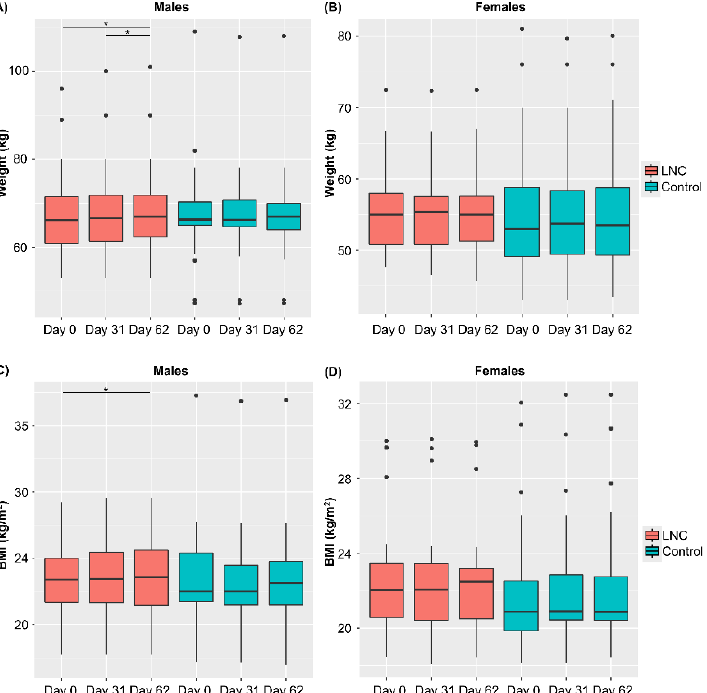
Figure 2. Changes in body weight and BMI following ingestion of SONOMONO NATTO POWDER CAPSULES TM . Each dot represents outliers. ( A ) Wight of males, ( B ) weight of females, ( C ) BMI of males, ( D ) BMI of females. Significant increase in weight was observed between samples collected from males in the LNC (lyophilized natto capsules) group on Day 0 and 62 and on Day 31 and 62. Furthermore significant increase in BMI was observed between samples collected from males in the LNC group on Day 0 and 62. * p < 0.05.